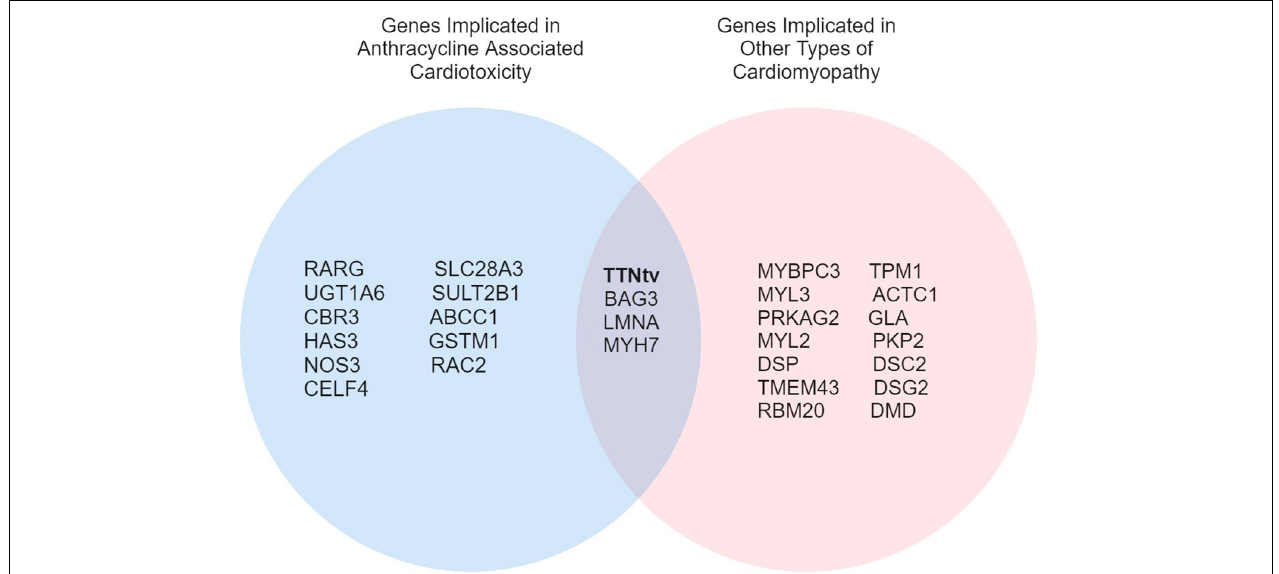
FIGURE 1 | A Venn diagram of overlapping genes implicated in ACT and other types of